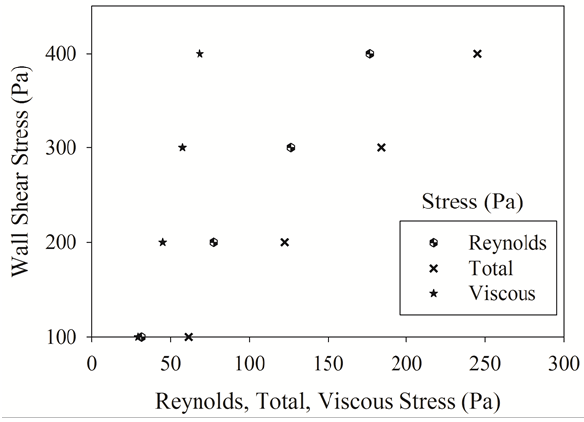
Figure 10. Changes of area-averaged Reynolds, total, and viscous stress with four different wall shear stresses (first column in Table 2).